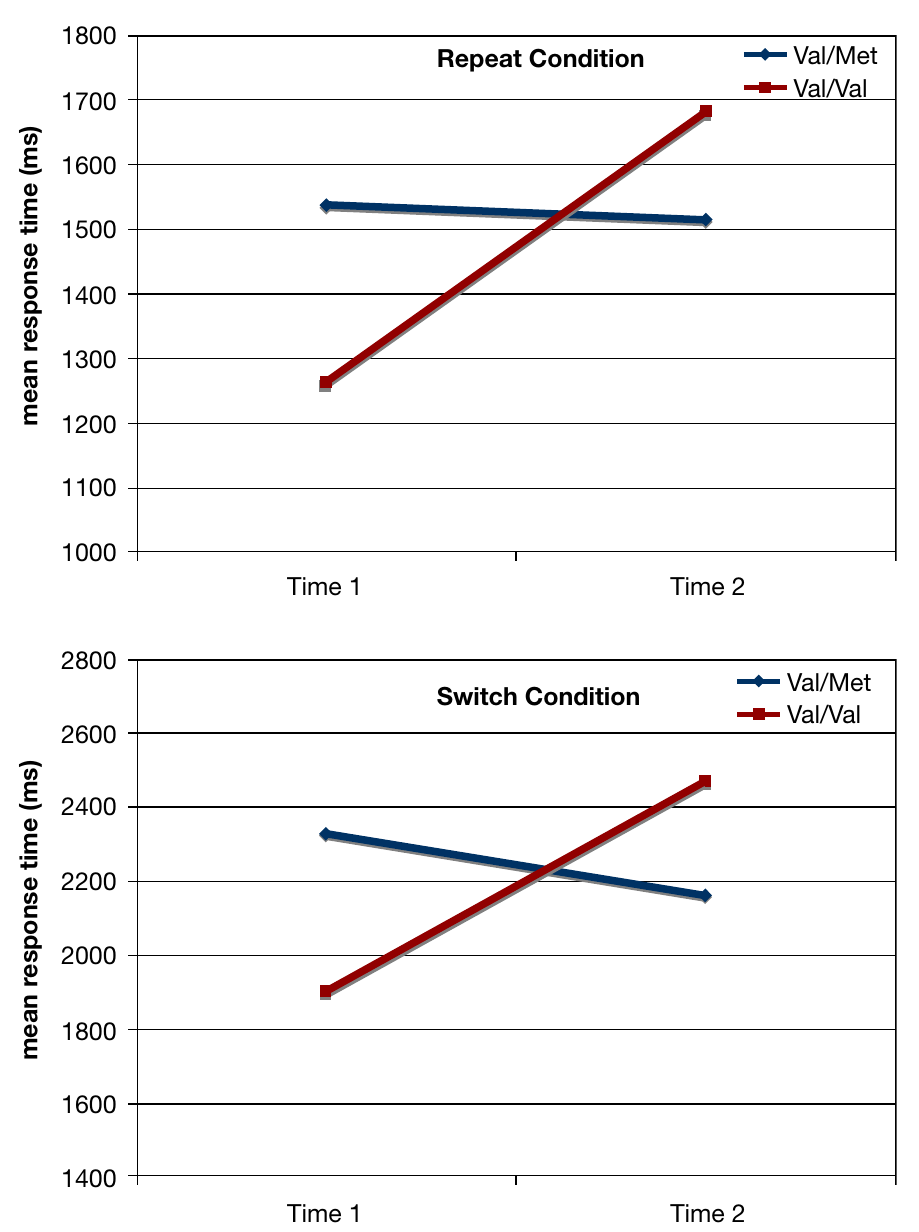
Figure 2 | Results from the task-switching paradigm as a function of the BDNF polymorphism and Time for each condition. Only the Val/Val homozygotes experienced a decline in performance for both the repeat and switch conditions, whereas the Val/Met carriers showed no decline over the 10-year